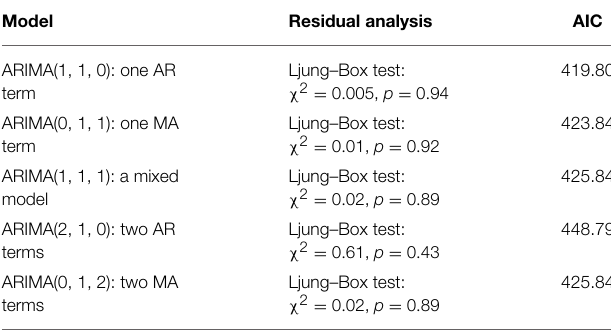
TABLE 2 | Comparison of different ARIMA models.